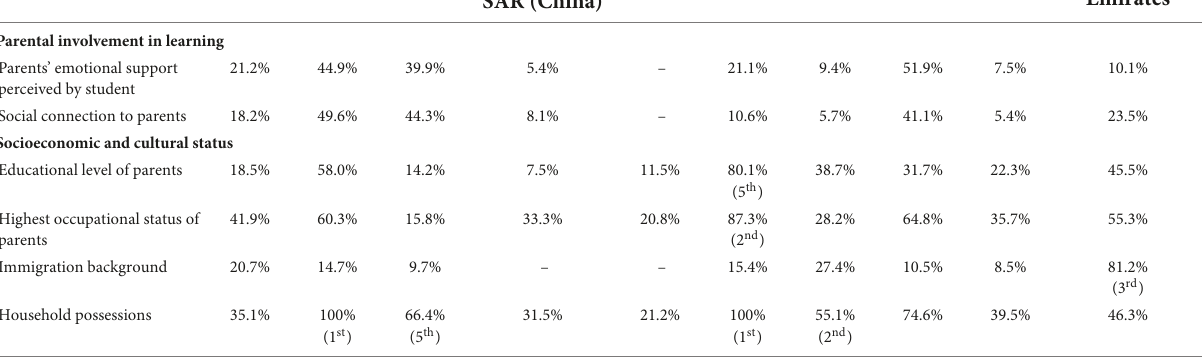
TABLE 7 Standardised importance of the independent family